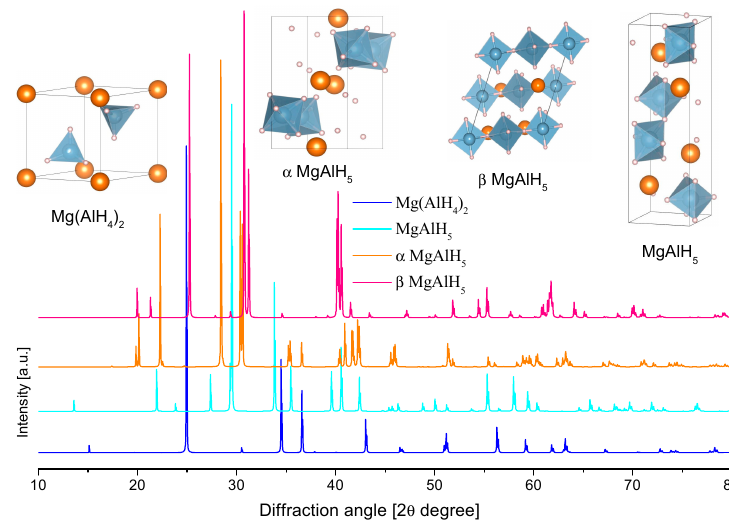
Figure 14. Crystal structure of magnesium alanates and their calculated diffraction patterns ( λ = Cu k α 1 ).